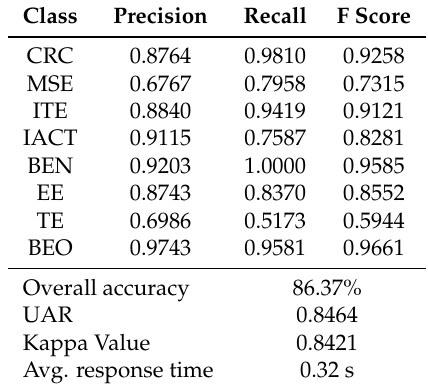
Table 4. Accuracy parameters result for eight building classification.